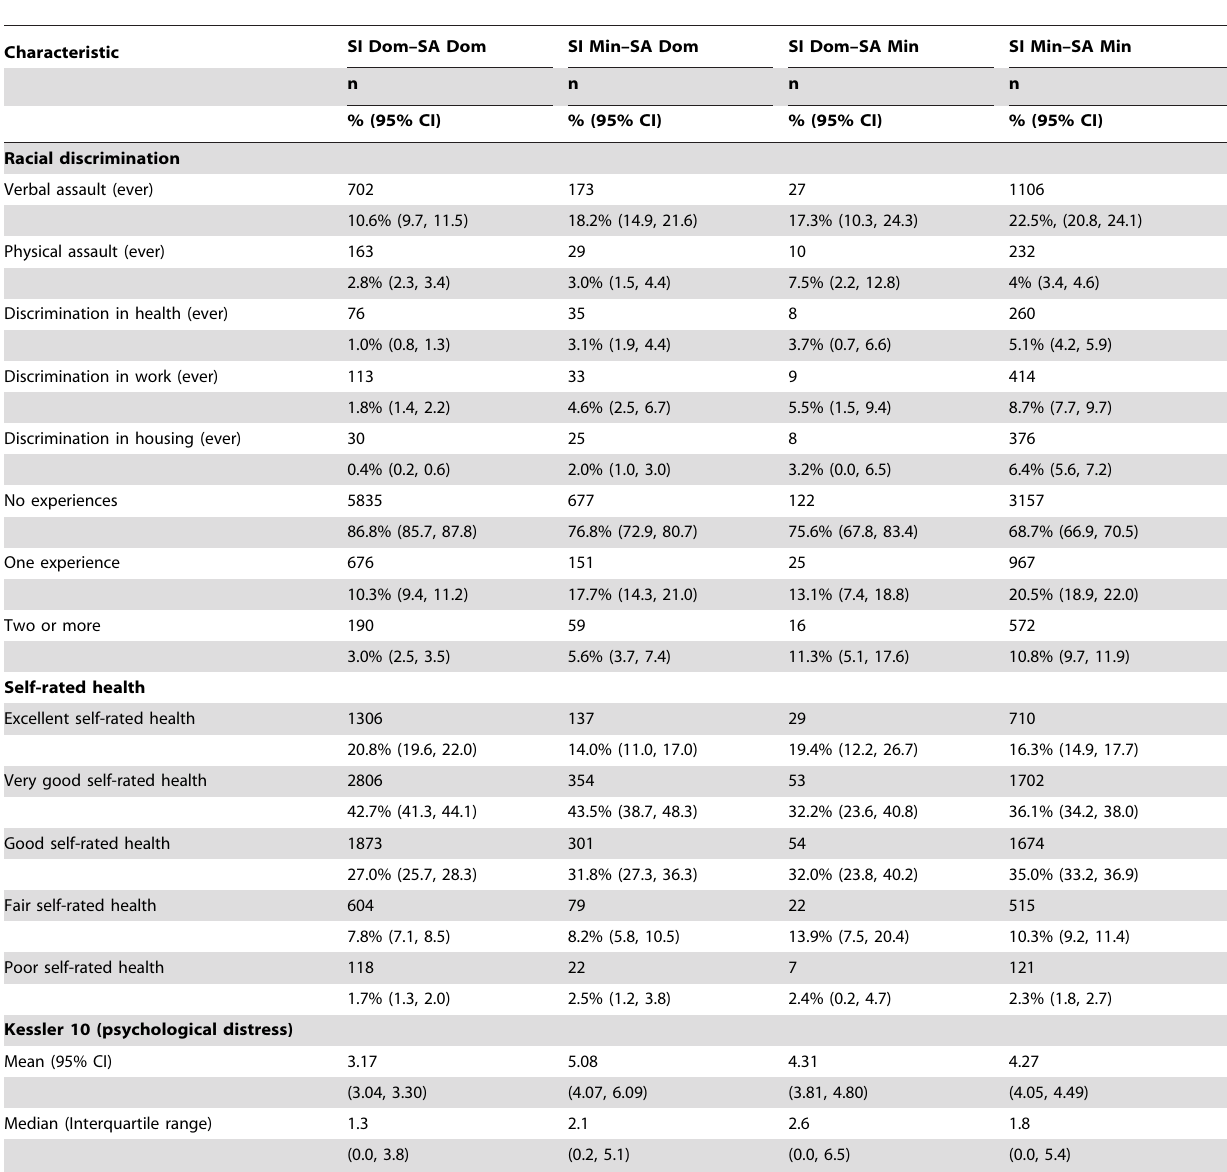
Table 4. Prevalence of racial discrimination exposures and health outcomes by the four self-identified–socially-assigned ethnicity categories a